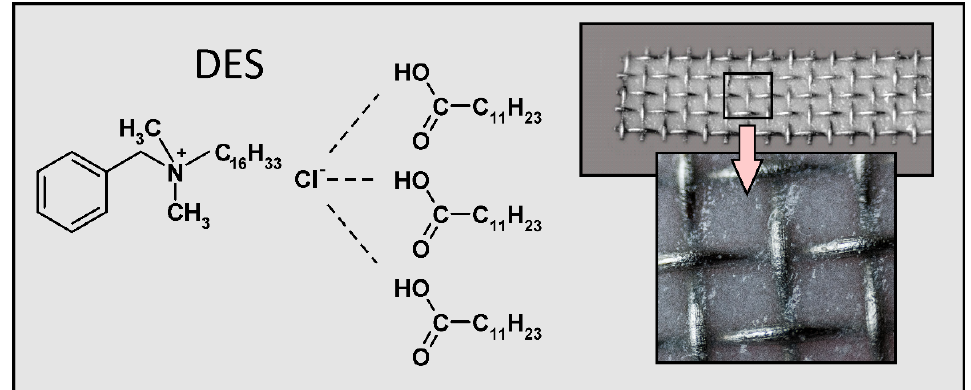
Figure 1. The structure of synthesized DES and its photography.